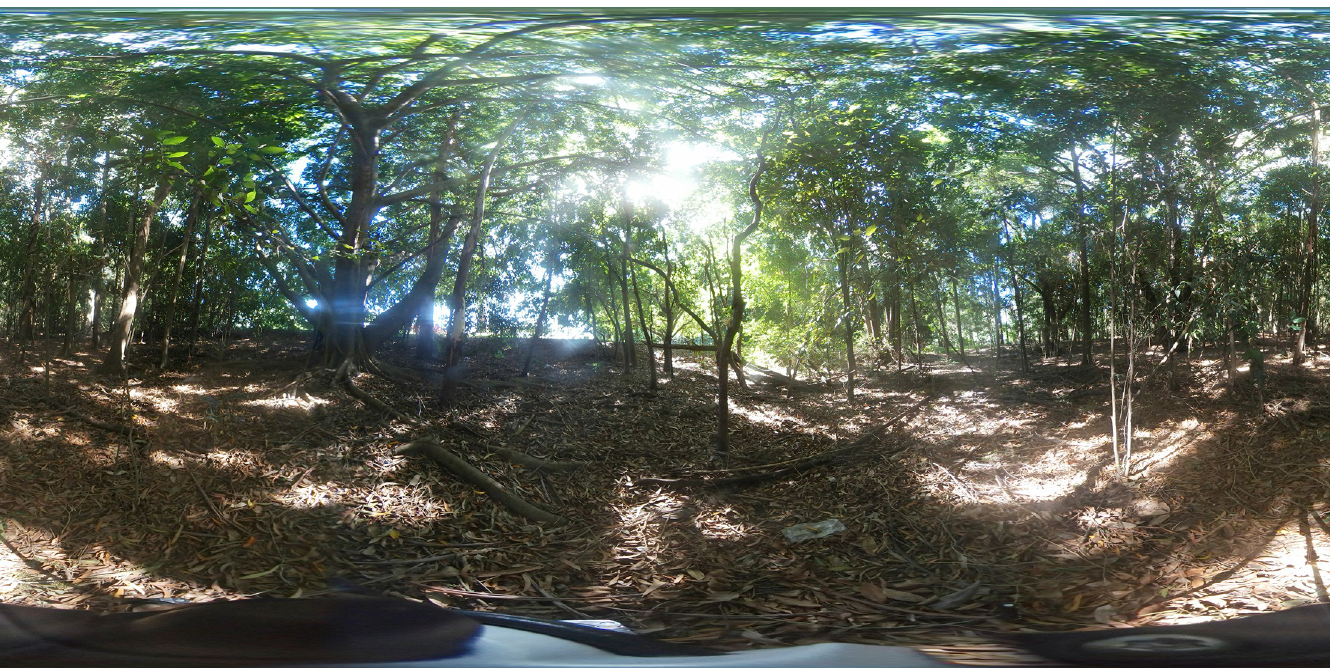
Fig 2. A 360-degree image. Used for virtual reality expert elicitation, showing a site where a koala had been observed during a ground survey. Image by Grace Heron, December 2017.